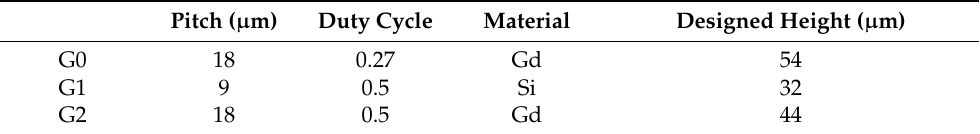
Table 1. Parameters of neutron gratings.